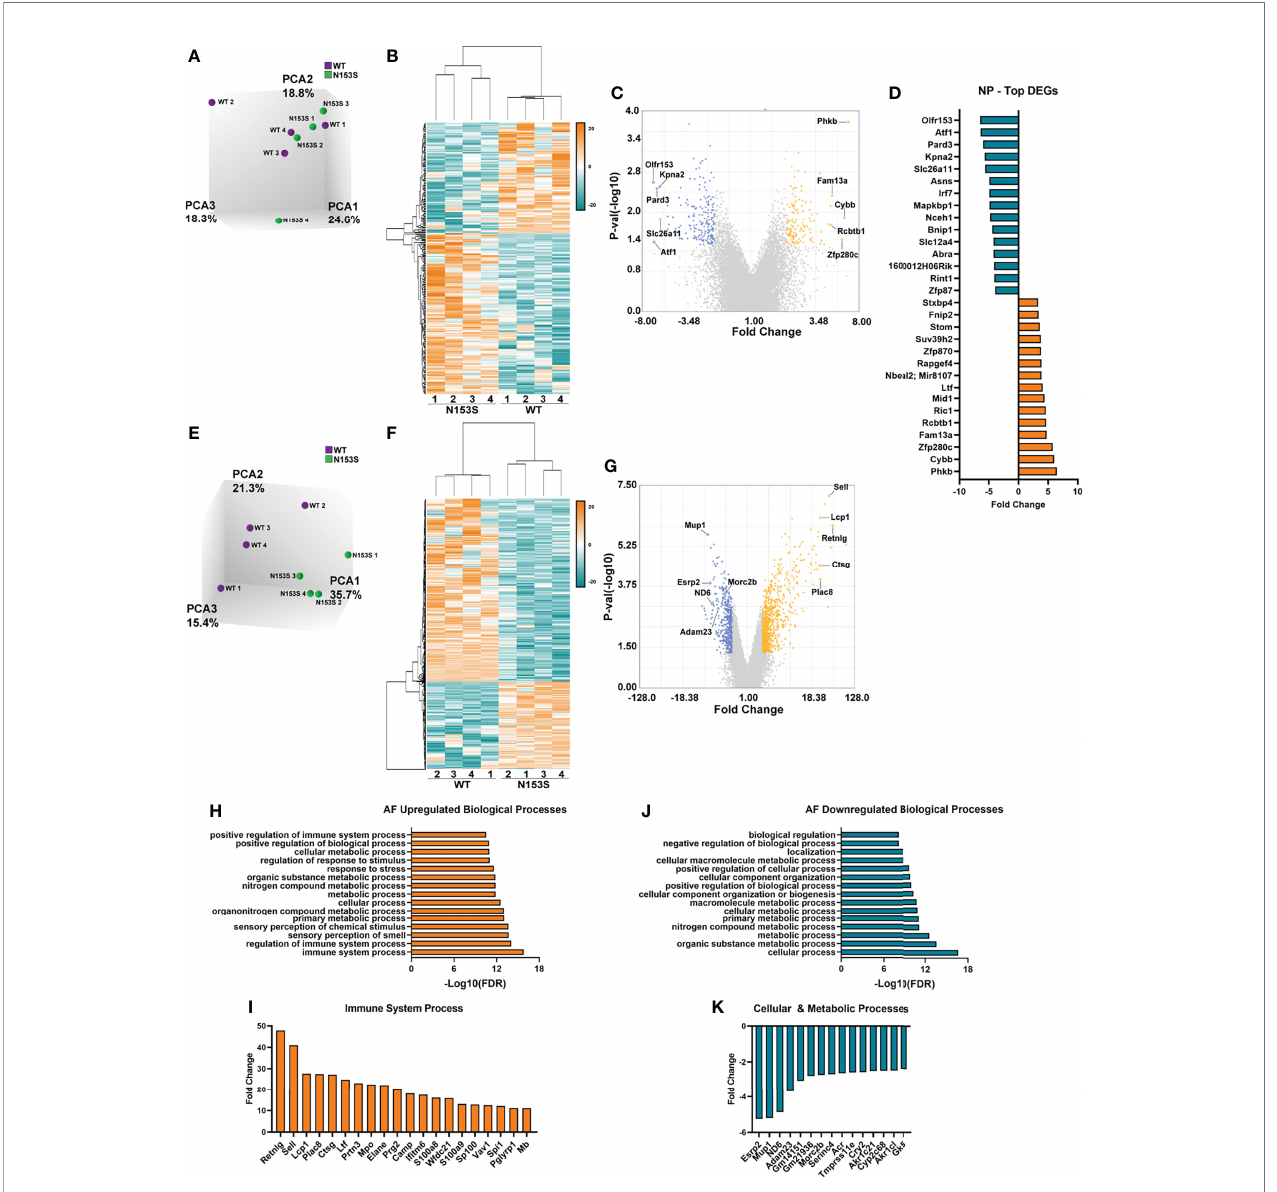
FIGURE 6 | STING activation results in more prominent transcriptomic changes in the AF than the NP of N153S mice. (A) Principal component analysis (PCA) of 6- month-old WT and N153S NP tissues (n = 4 animals/genotype). (B) Heatmap of z-scores for NP DEGs de fi ned by p < 0.05 and 2 < fold change < -2. (C) Volcano plot of DEG p-value plotted against fold change, showing 134 upregulated and 193 downregulated genes in N153S NP tissues. (D) DEGs identi fi ed in the NP with the greatest fold change. (E) PCA of 6-month-old WT and N153S AF tissues (n = 4 animals/genotype). (F) Heatmap of z-scores for AF DEGs de fi ned by p < 0.05 and 2 < fold change < -2. (G) Volcano plot of DEG p-value plotted against fold change, showing 856 upregulated and 465 downregulated genes in N153S NP tissues. (H) Representative GO biological processes derived from upregulated genes in N153S AF tissues. (I) DEGs with the greatest fold change within the immune system process GO term. (J) Representative GO biological processes derived from downregulated genes in N153S AF tissues. (K) DEGs with the greatest fold change within the cellular process and metabolic process GO